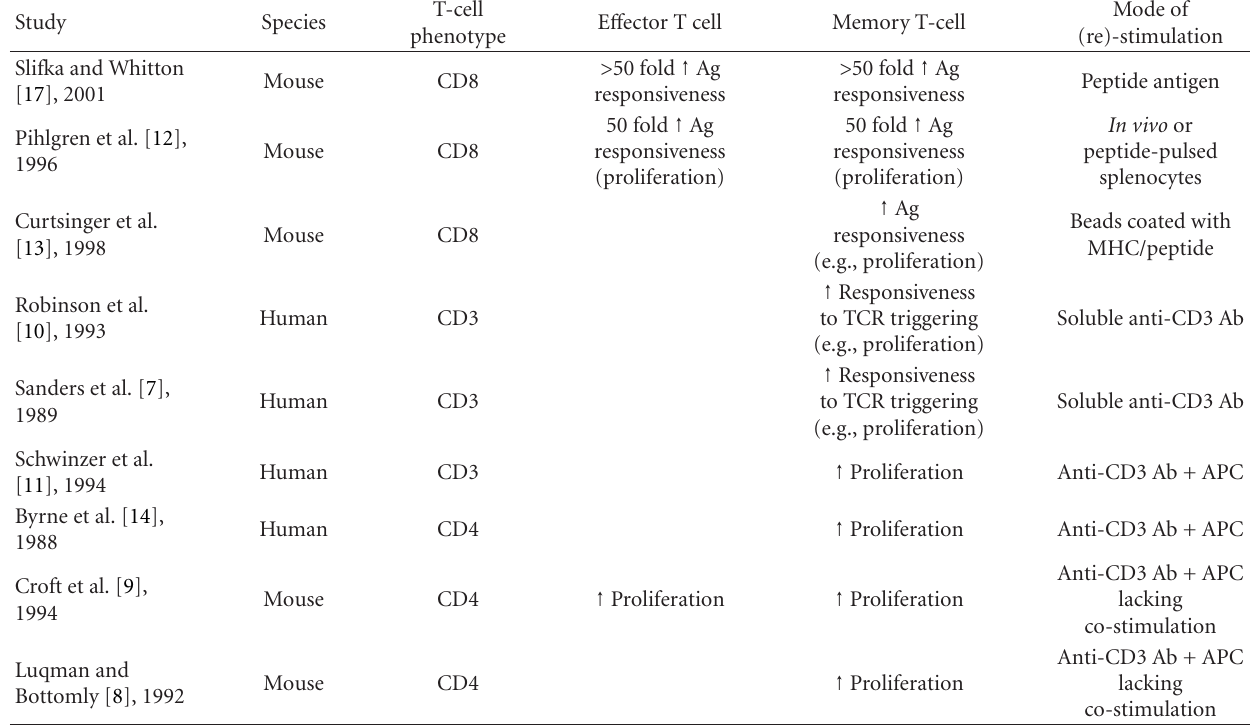
Table 1: Studies describing di ff erences in antigen sensitivity between na¨ıve and primed T cells. Di ff erences listed are in comparison to na¨ıve T